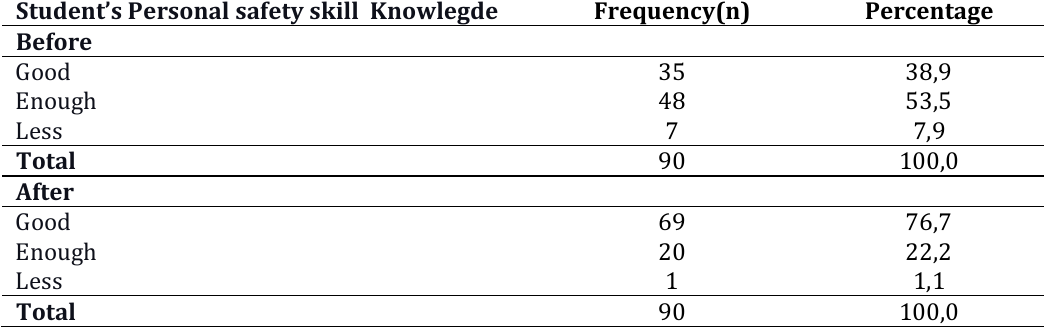
Respondents Frequency Distribution Based on Personal Safety Skills Knowledge of Students Before and After playing “Cards in Pairs” Games at Public Elementary School 2 Serangan in 2018 Student’s Personal safety skill Knowlegde